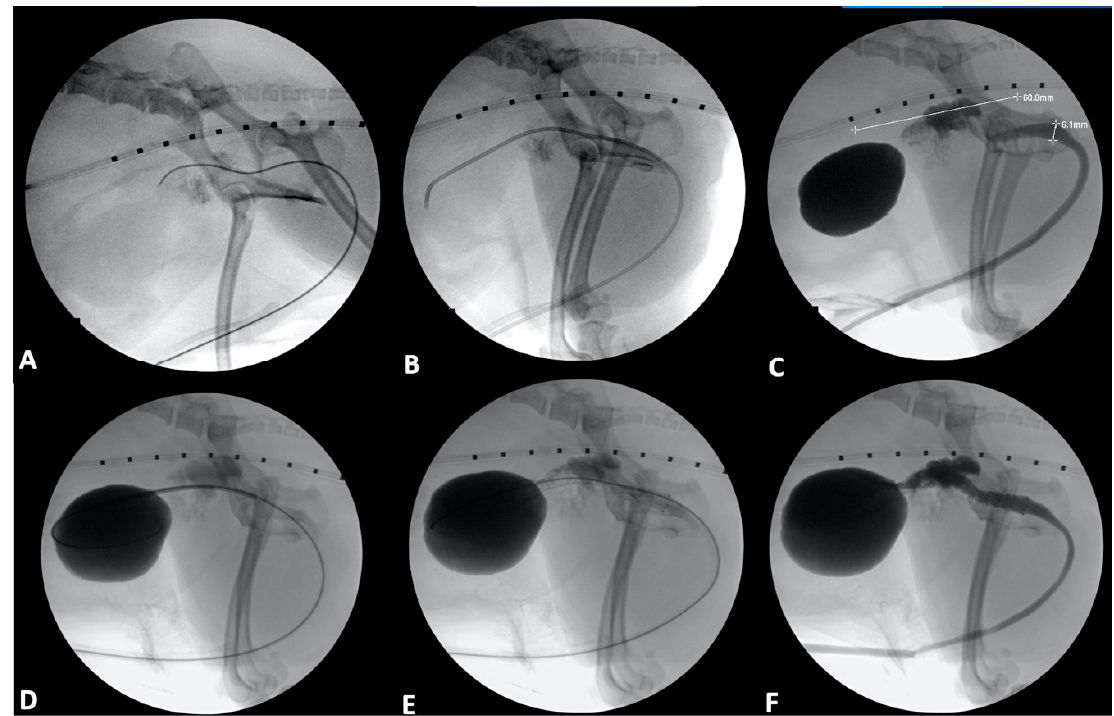
Figure 3. Urethral stenting in a 9-year-old male castrated toy poodle. ( A ): A 0.035-inch hydrophilic guidewire has been passed into the urethra and further into the trigone of the bladder. ( B ): A 4 French angled catheter has been introduced over the guidewire and advanced into the bladder. ( C ): A contrast cystourethrogram has been performed, and initial measurements of the region of the urethra affected by tumor have been obtained (white line extending cranial to caudal), as has a urethral diameter (white line extending dorsal to ventral). Note the infiltration of contrast into the prostate through the prostatic ductules. ( D ): A stent has been introduced into the bladder over the guidewire. ( E ): The stent has been deployed. ( F ): The angled catheter was passed over the guidewire, and a contrast cystourethrogram was performed to confirm patency of the urethra in the region of the stent.